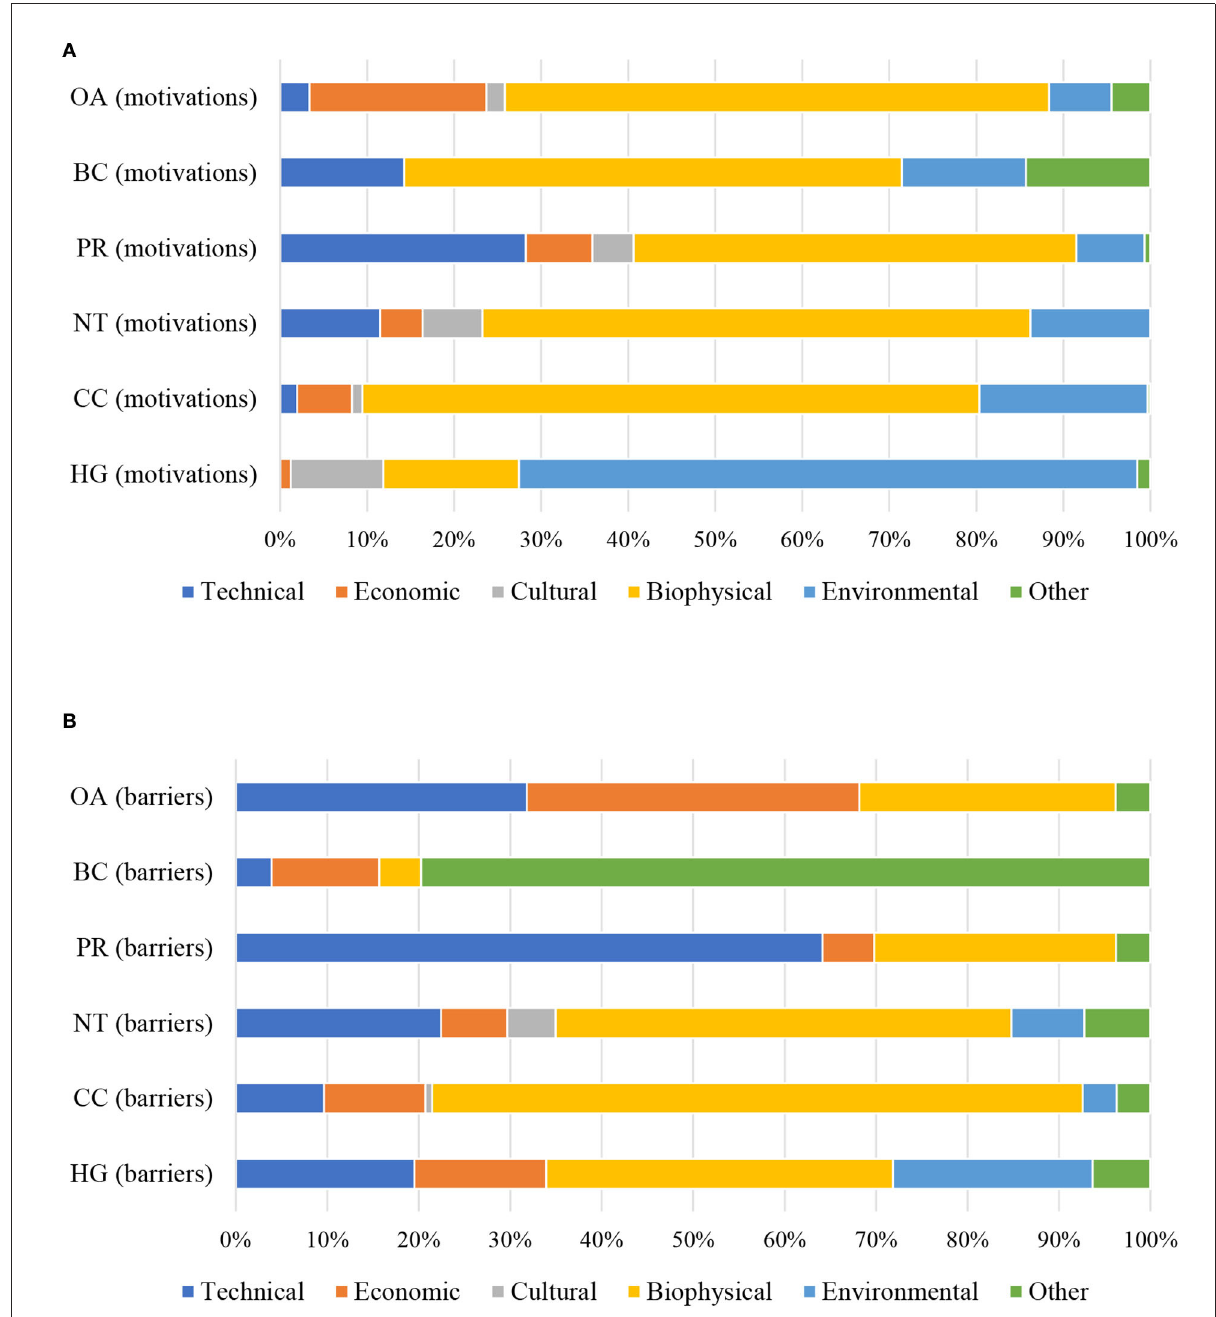
FIGURE8 Categories of motivations for (A) and barriers to (B) the adoption of soil carbon sequestration practices by winegrowers in France. OA, organic amendments; BC, biochar amendments; PR, returning pruning residues to the soil; NT, no-tillage; CC, cover cropping; HG,